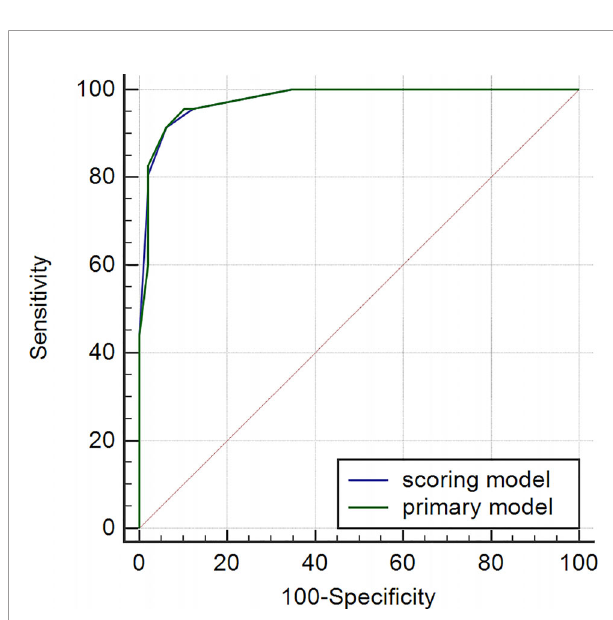
FIGURE 4 | ROC of primary and scoring